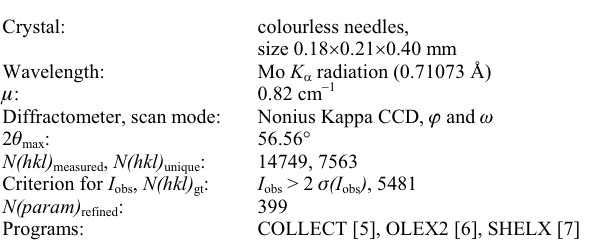
Table 1. Data collection and handling.